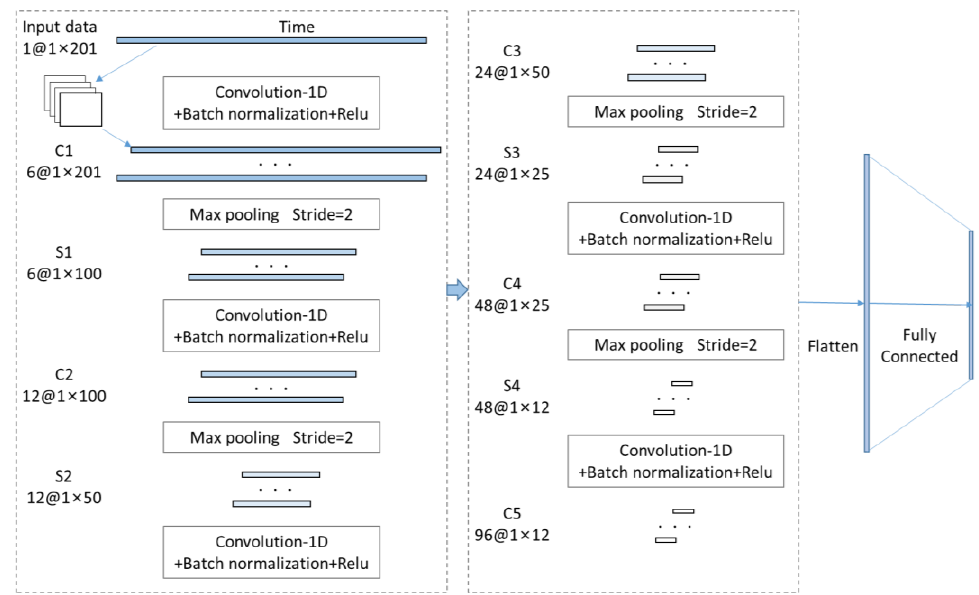
Figure 2. The network architecture of CNN structure.